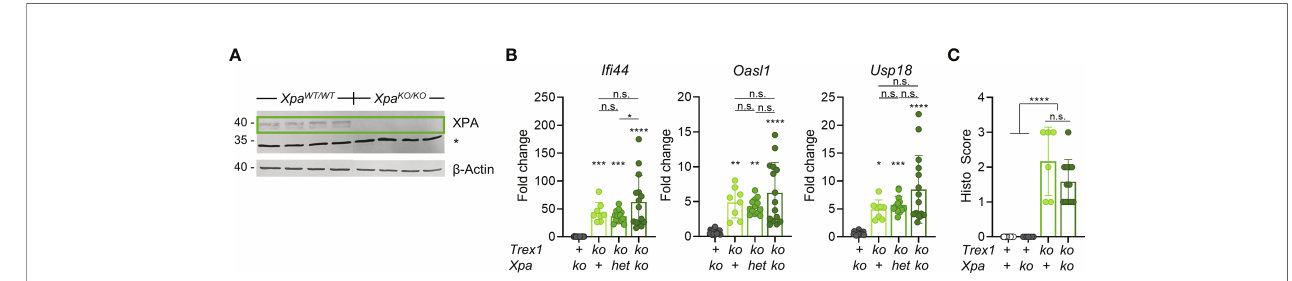
FIGURE 2 | Additional inactivation of NER has no impact on the spontaneous IFN response of Trex1 -/- mice. (A) Western blot analysis of XPA expression in protein extracts from ear tissue from control and XPA -/- mice. * non-speci fi c band at 34 kDa. (B) ISG transcript levels in total blood cells from 6 week-old mice of the indicated genotypes quanti fi ed by qRT-PCR. The Trex1 D 478 null allele generated in this study was used. Fold change compared with mean of WT controls (n = 16) is shown ( Trex1 -/- n = 8, Xpa -/- n = 18, Trex1 -/- Xpa WT/- n = 13, Trex1 -/- Xpa -/- n = 15. (C) Quanti fi cation of myocarditis intensity in H&E-stained sections of heart tissue from 9-11 week-old mice of the indicated genotypes (WT n = 15, Xpa -/- n = 7, Trex1 -/- n = 6, Trex1 -/- Xpa -/- n = 12). See M&M for heart in fl ammation score. ****p < 0.0001, ***p < 0.001, **p < 0.01, *p < 0.05, n.s., not signi